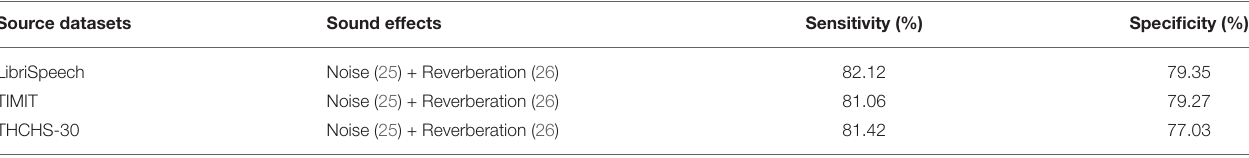
TABLE 2 | Performance dropped only slightly on two additional synthetic datasets TIMIT (English) and THCHS-30 (Mandarin). Source